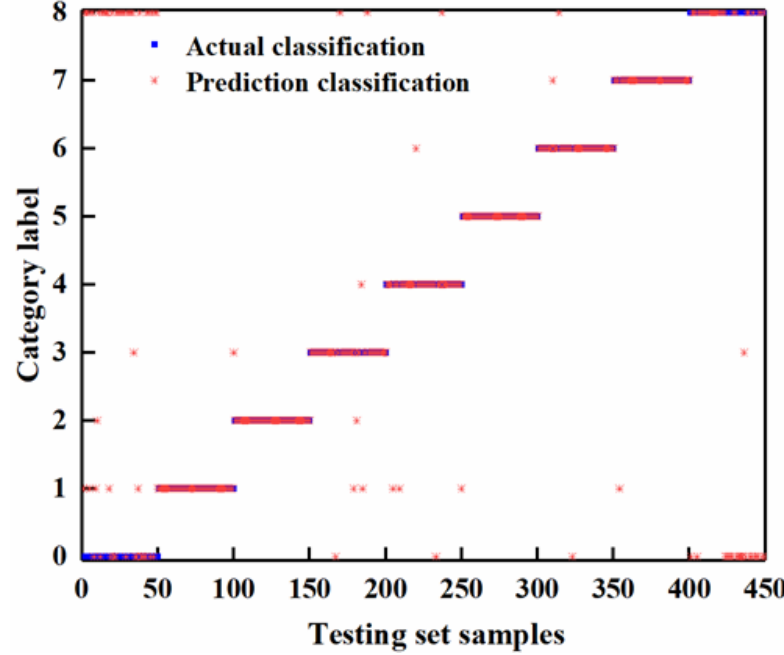
Figure 7. Predictive classification results of the SVM algorithm.